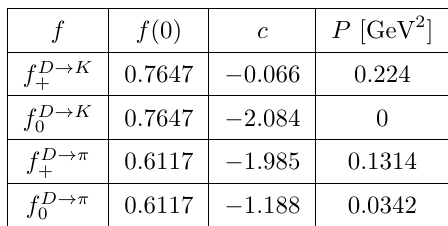
Table 11 . Best (cid:12)t parameters values for the form factors in B ! D and B ! (cid:25) transitions from ref. [128].